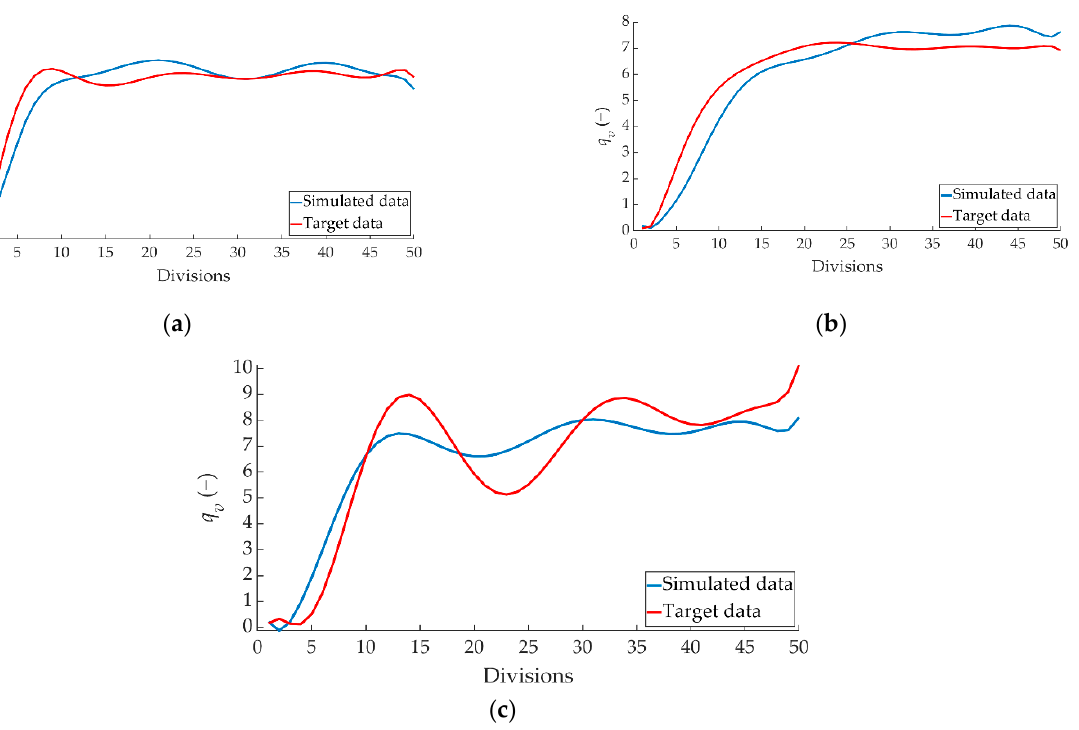
Figure 18. Comparison between ANN-simulated data and target q v data for the right pressure sensor for braking at a speed of 70 km/h for the type: ( a ) maintained, ( b ) progressive and ( c ) emergency. Figure 19 shows the comparison between the simulated data and the target data con- cerning the evolution of q t over the 50 divisions performed for the left pressure sensor.